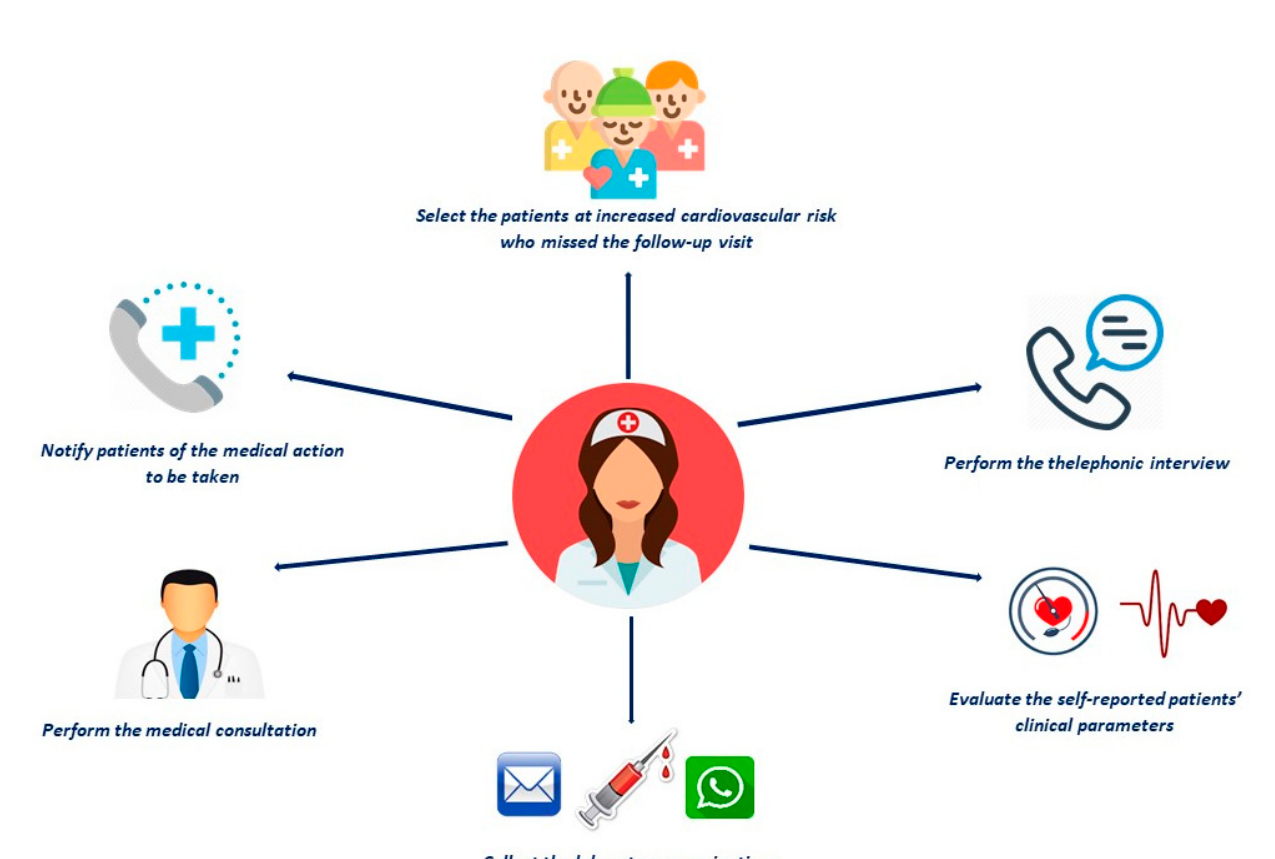
Figure 4. The nursing-based teleconsultation model.